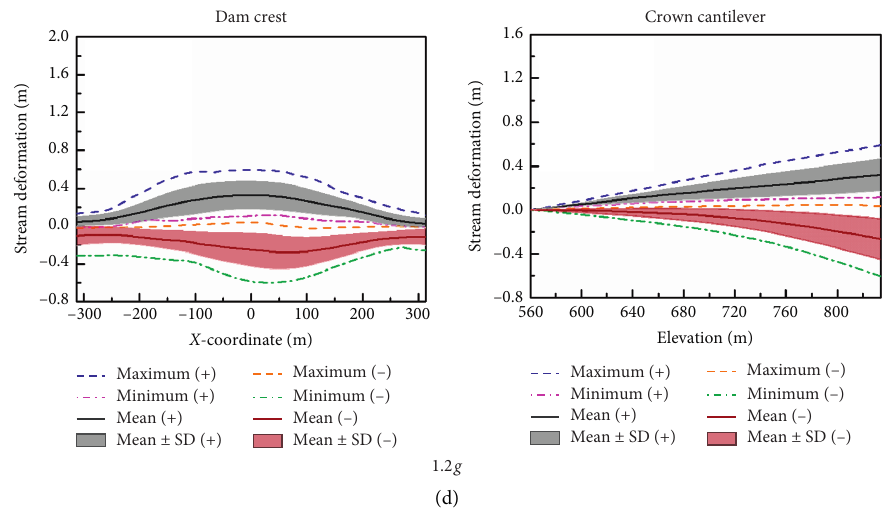
Figure 13: Distributions of stream deformation along the crest and the crown cantilever at different